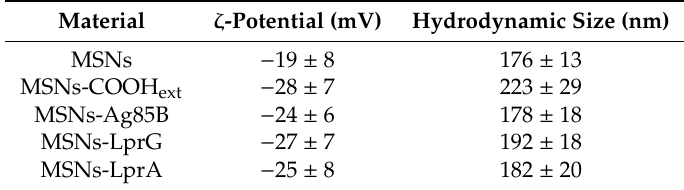
Table 2. ζ -potential values and hydrodynamic particle size in water medium of MSN